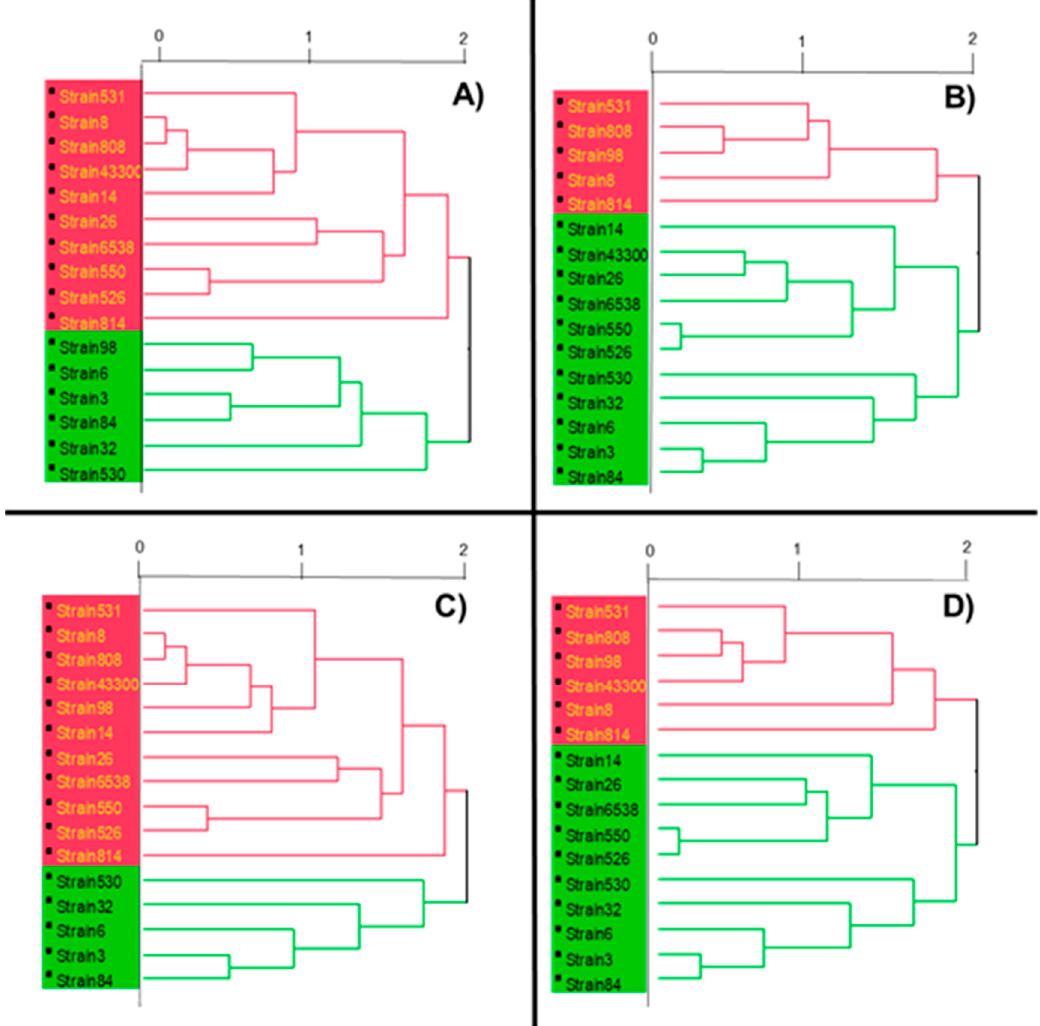
Figure 1. Dendrograms constructed using the Ward method for the cluster analysis of fatty acid from ATCC and clinical strains of Staphylococcus aureus : ( A ) fatty acid; ( B ) fatty acid and antibiotic susceptibility profile; ( C ) fatty acid and hydrophobicity index; ( D ) fatty acid, antibiotic susceptibility profile, and hydrophobicity index. The horizontal axis of the dendrogram represents the distance or dissimilarity between clusters. The vertical axis represents the objects and clusters. The horizontal axis is calculated as “even spacing”, so 2 represents the maximal distance, 1 the intermediate distance and 0 no distance.